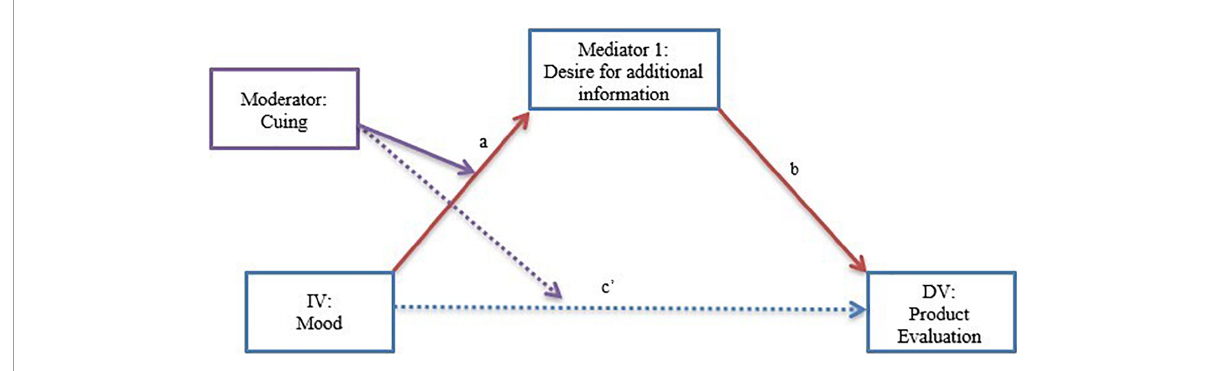
FIGURE2 Experiment 3: Moderated mediation (Model 8, Hayes, 2017) the effects of cuing interaction on the relationship between mood and product evaluation through desire for additional information. Note: the analysis shows a significant path through desire for additional information (a → b, p < 0.05) and no direct path (c (cid:48) , ns